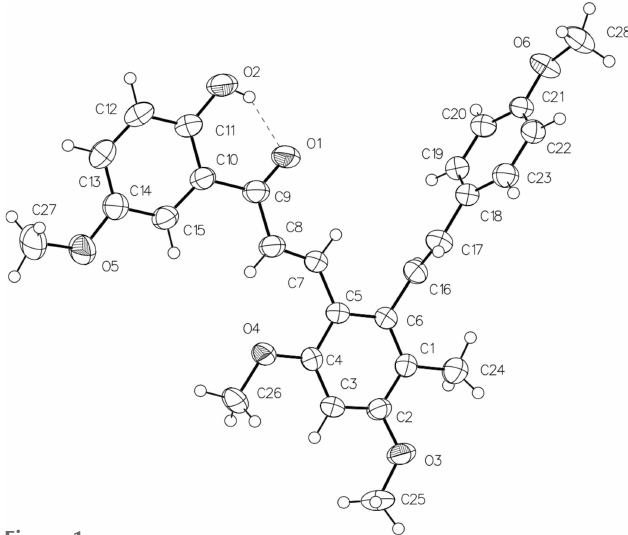
Figure 1 The molecular structure of (I) with displacement ellipsoids drawn at the 30% probability level.